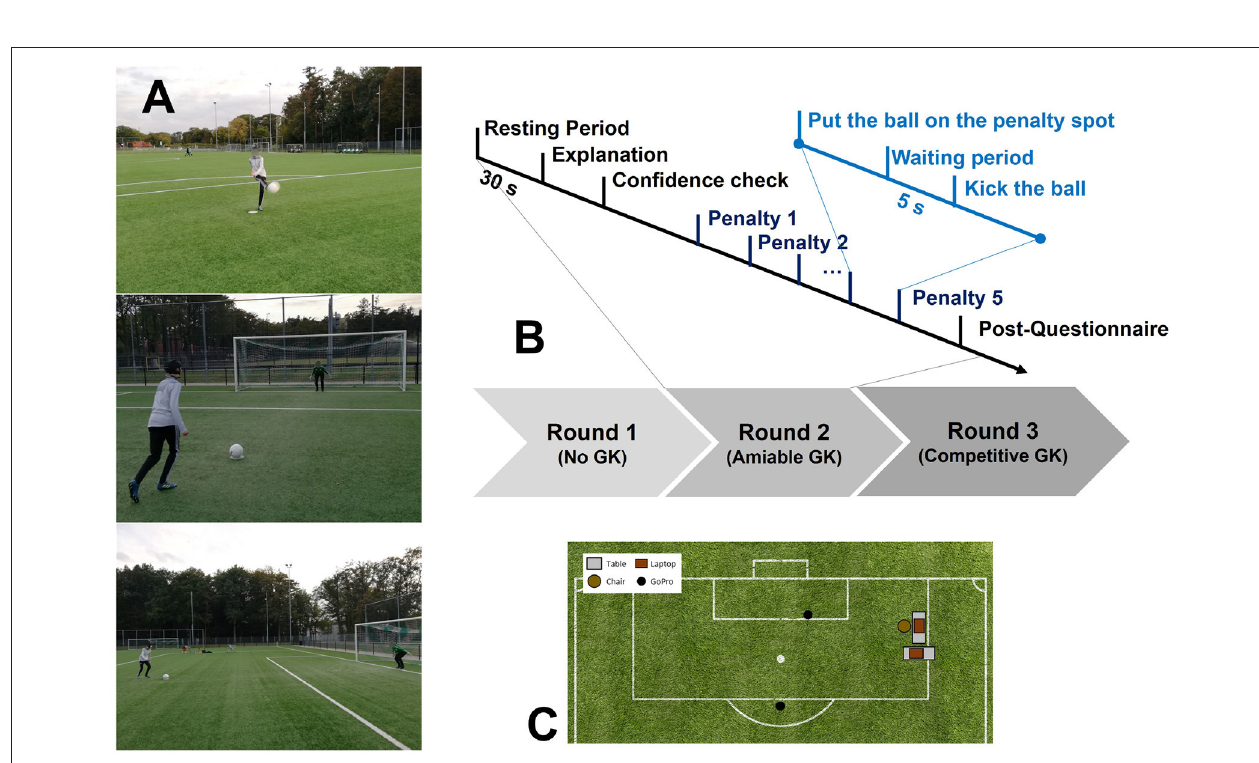
FIGURE 2 | The experimental setting: (A) pictures of the experiment from the front (top), back (middle), and side (bottom) angle; (B) experimental protocol; (C) placement of the equipment. The laptop close to the chair was used by the participants to fill in the questionnaires. The GoPro camera that was closest to the goal was aiming at the player and the other camera was aiming at the